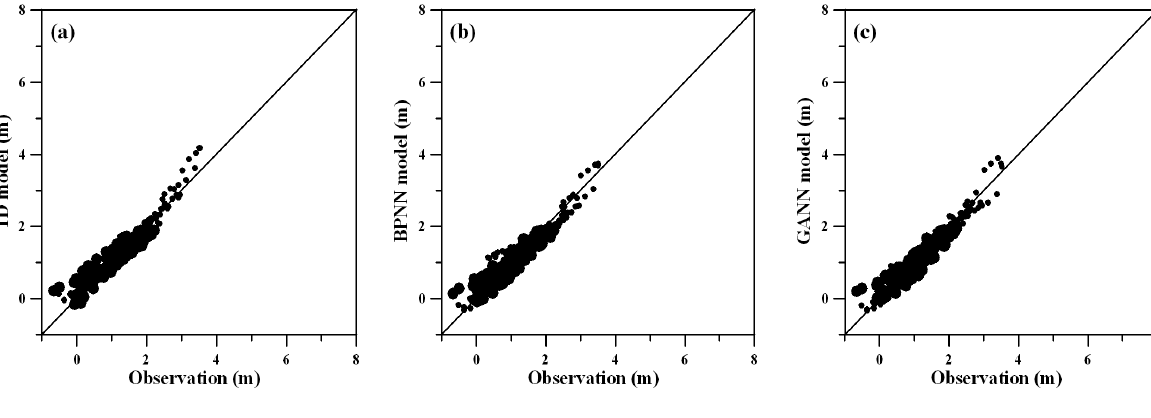
Figure 9. The scatter plots of simulated and observed water stages using ( a ) the one-dimensional flood routing hydrodynamic model; ( b ) the BPNN model; and ( c ) the GANN model for the verification phase for two typhoon events and four